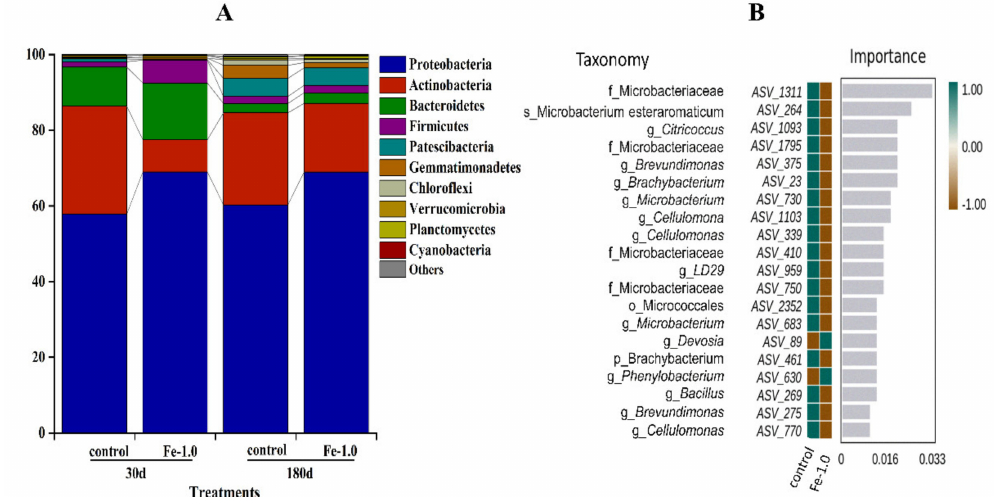
Figure 4. Relative abundance and taxonomic differences of bacteria in control and Fe-1.0. ( A ) Micro- biome composition in the two groups at the phylum level; ( B ) Taxonomy of the top 20 bacteria in control and Fe-1.0 in terms of the